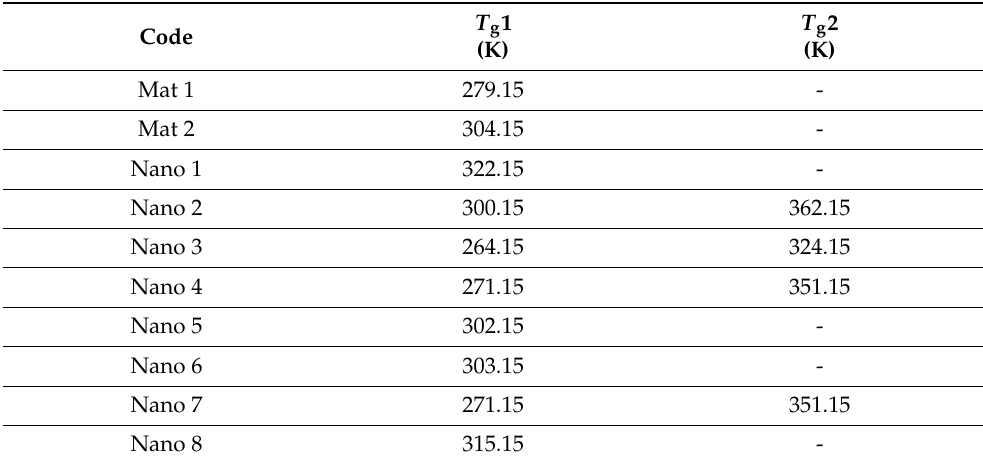
Figure 6. DSC thermograms of Mat 2 ( A ), Mat 1 ( B ), Nano 3 ( C ), Nano 4 ( D ), Nano 7 ( E ), and Nano 8 ( F ). Table 4. Glass transition temperatures of the pure MAA–BA copolymers and the CNTs o-OCl-MAA –BA or CNTs r-OCl-MAA –BA